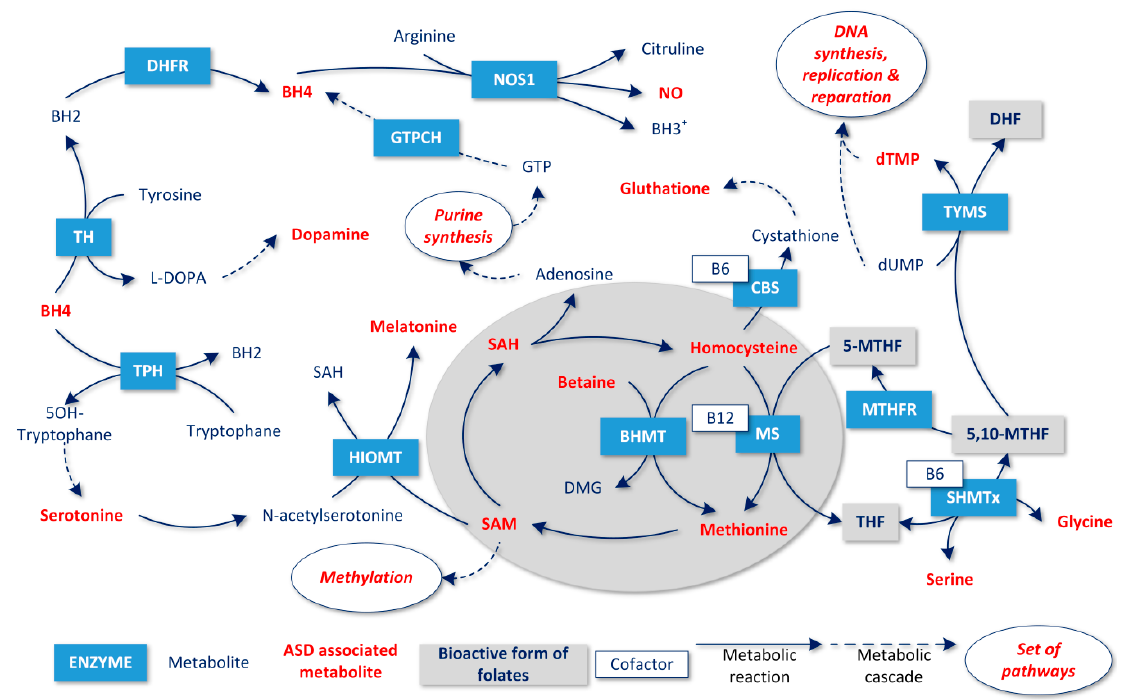
Figure 1. Involvement of folate metabolites associated with Autism spectrum disorders (ASD) (in red).